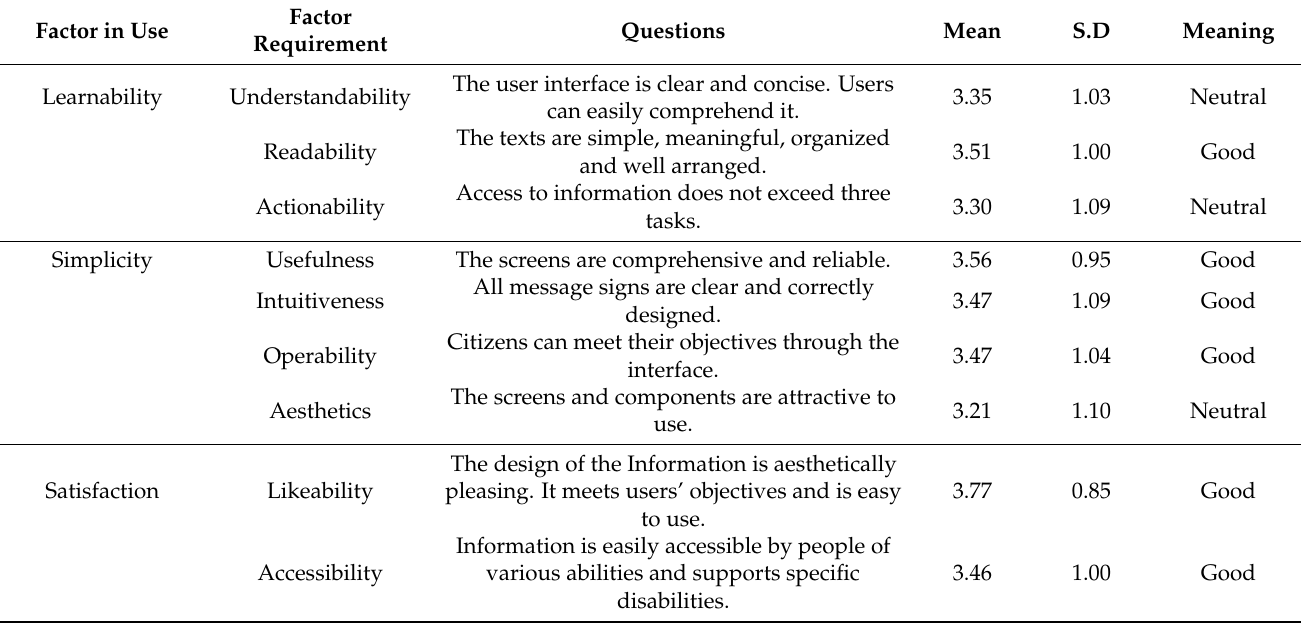
Table 2. The result of the questionnaire represents the citizens’ perspectives on the three usability factors or factor in use: learnability, simplicity, and